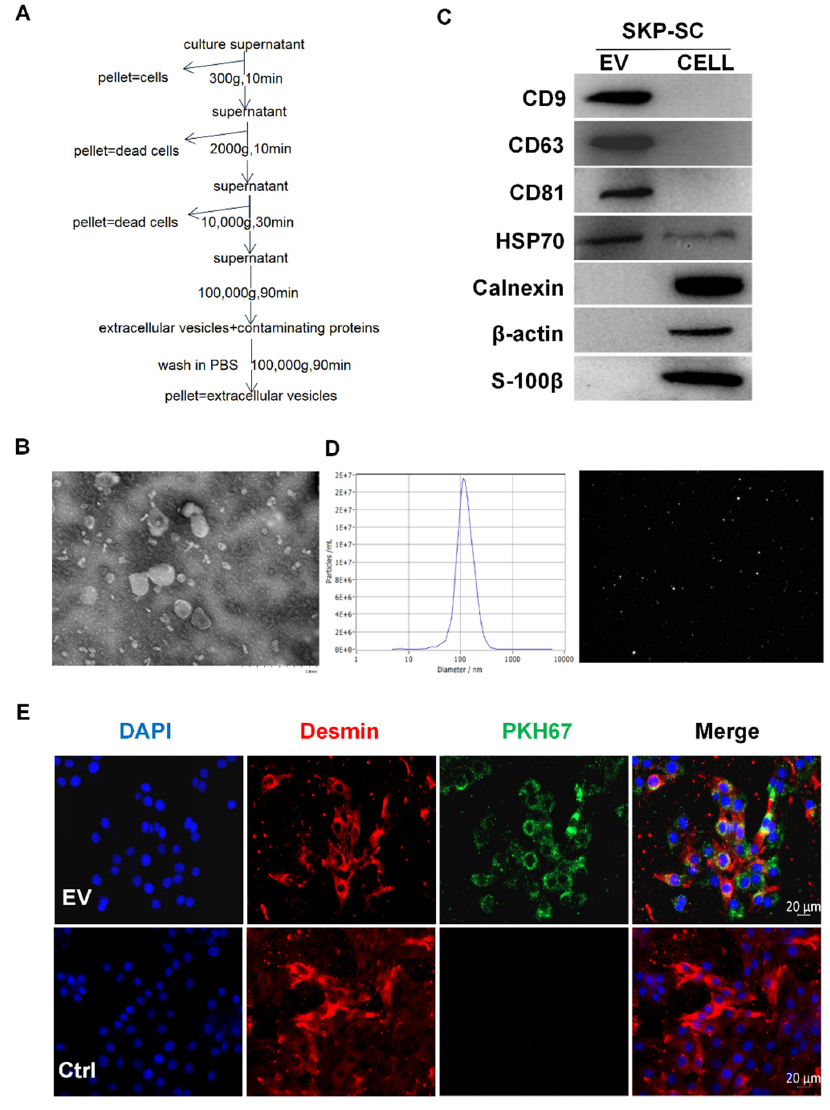
Figure 1. Identification of EVs from SKP-SCs. ( A ) Schematic diagram of gradient ultracentrifugation steps for separating and extracting EVs derived from SKP-SCs. ( B ) Representative transmission electron microscope images of SKP-SC-EVs. Scale bar = 500 nm. ( C ) Western blot analysis shows positive expression of exosomal markers CD9, CD63, CD81, and HSP70 in EVs. Calnexin, β -actin, and S-100 β in SKP-SCs acted as control markers positively expressed in SKP-SCs. ( D ) NTA of representative SKP-SC-EV particles. ( E ) Representative SKP-SC-EVs labeled with PKH67 (green) in the cytoplasm of C2C12 myoblasts (red label indicates myosin), and the nucleus labeled with DAPI (blue). Scale bar = 20 μ m. EVs, extracellular vesicles; SCs, Schwann cells; SKP, skin-derived precursors.